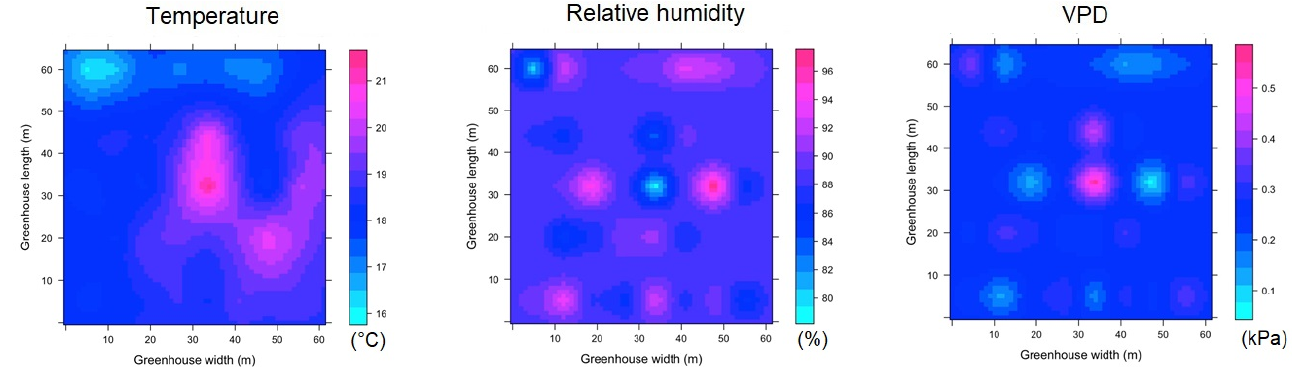
Figure A5. Spatial distribution predicted by kriging, for temperature, relative humidity and VPD in TG and for ESRL 3.